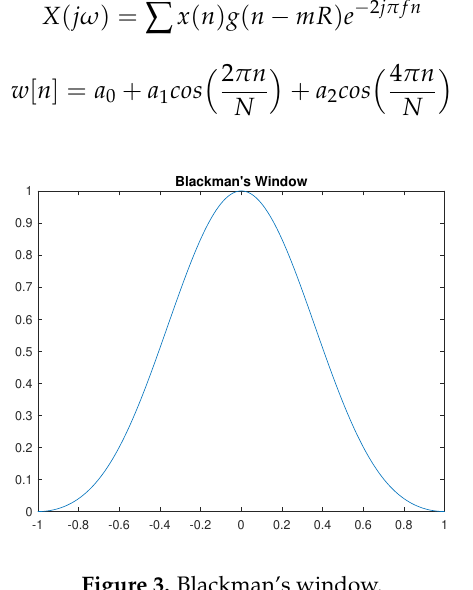
Figure 3. Blackman’s window.